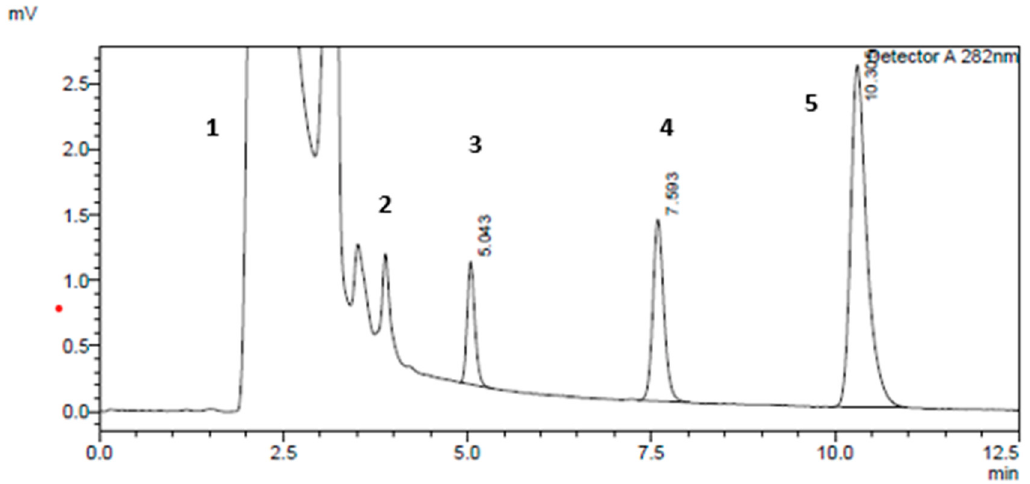
Figure 3. Typical HPLC chromatogram of CYP2E1 components with standard rat microsomal medium (40 min incubation of chlorzoxazone) at 282 nm wavelength detection with a 200-µM chlorzoxazone concentration. The peaks marked are: ( 1 ) the nicotinamide adenine dinucleotide phosphate hydrogen (NADPH)-regenerating system, ( 2 ) salicylic acid, ( 3 ) 6-hydroxychlorzoxazone, ( 4 ) phenacetin, and ( 5 ) chlorzoxazone, respectively.